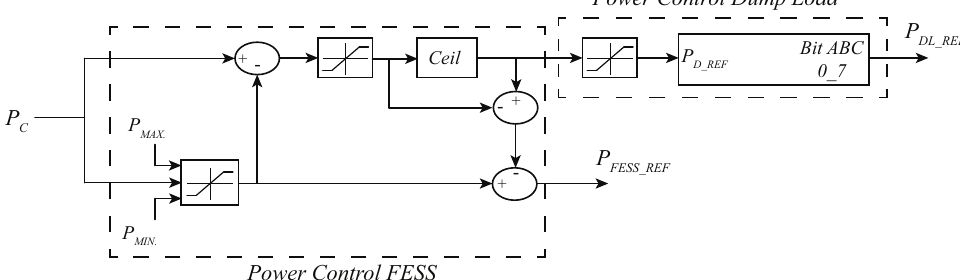
Figure 9. Power-Sharing control algorithm between the FESS and the